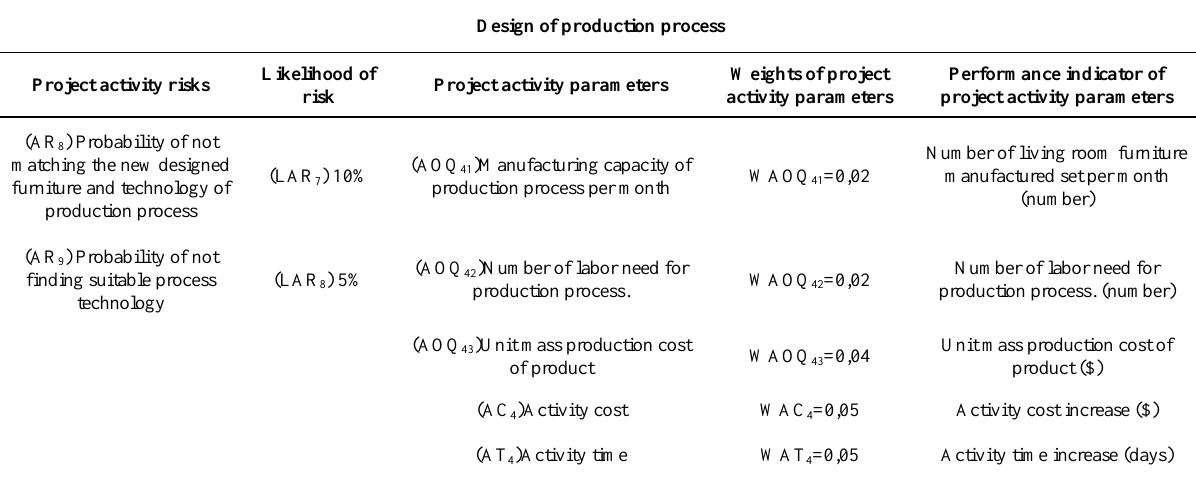
Table 5. TOPSIS information table of design of production process.